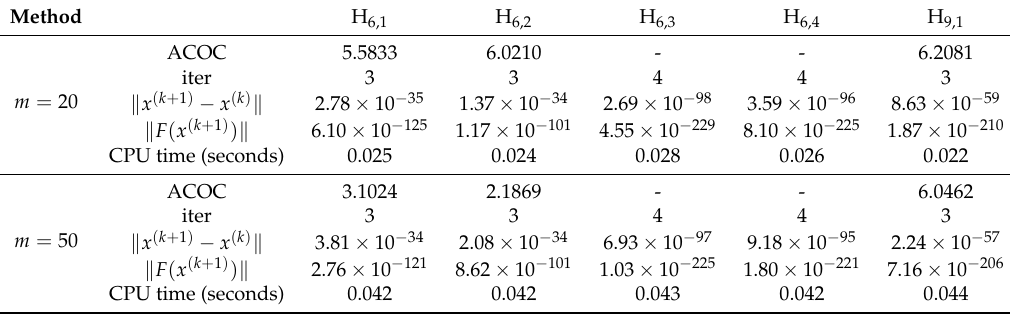
Table 1. Numerical results for conservative boundary problem.